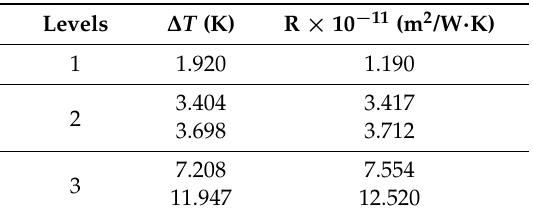
Figure 3 . The schematic of plot statistical means temperature distribution of graphene along a zigzag direction. ( a – d ) represent the gra0, gra1, gra2, and gra3, respectively. T able 1. Interfacial thermal resistance of different fractal levels.